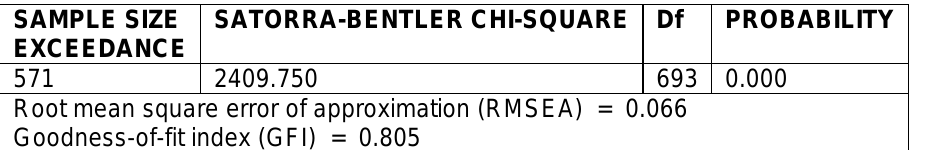
Table 7: fit indices - the influence of organisational variables on sales growth) SAMPLE